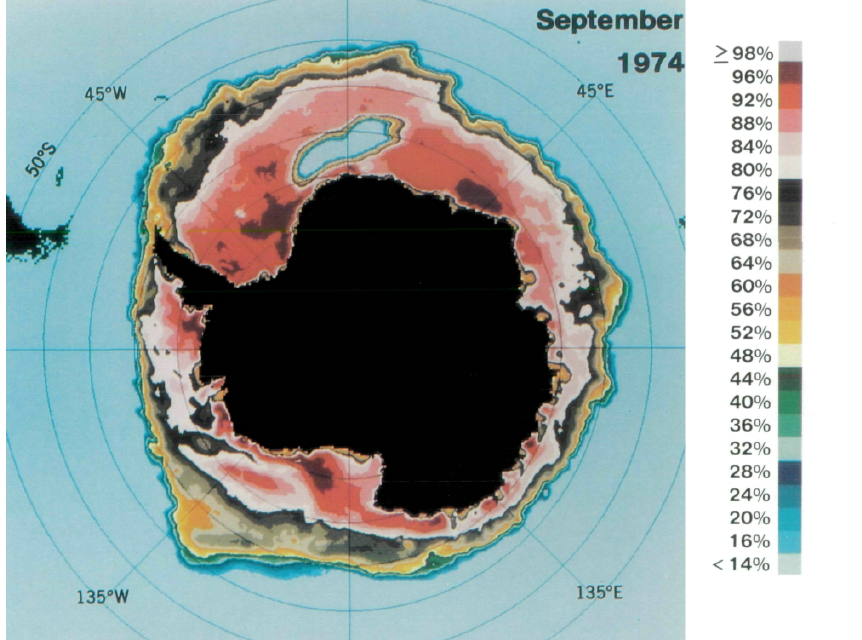
Figure 1. The Weddell Sea polynya in Austral winter, September 1974. Violet and red correspond to a high sea ice concentration, and light blue corresponds to open ocean. The great Weddell Sea polynya is visible across the Greenwich meridian. Figure from Zwally et al.